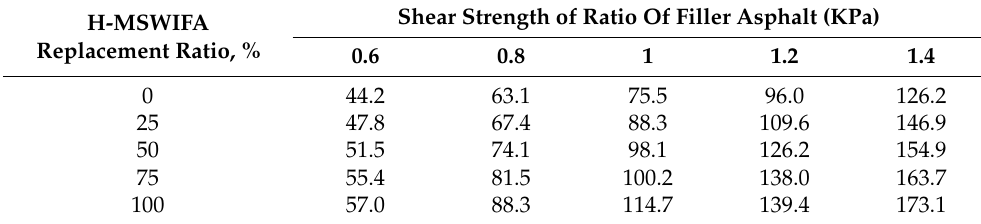
Table 5. Shear strength calculation results.